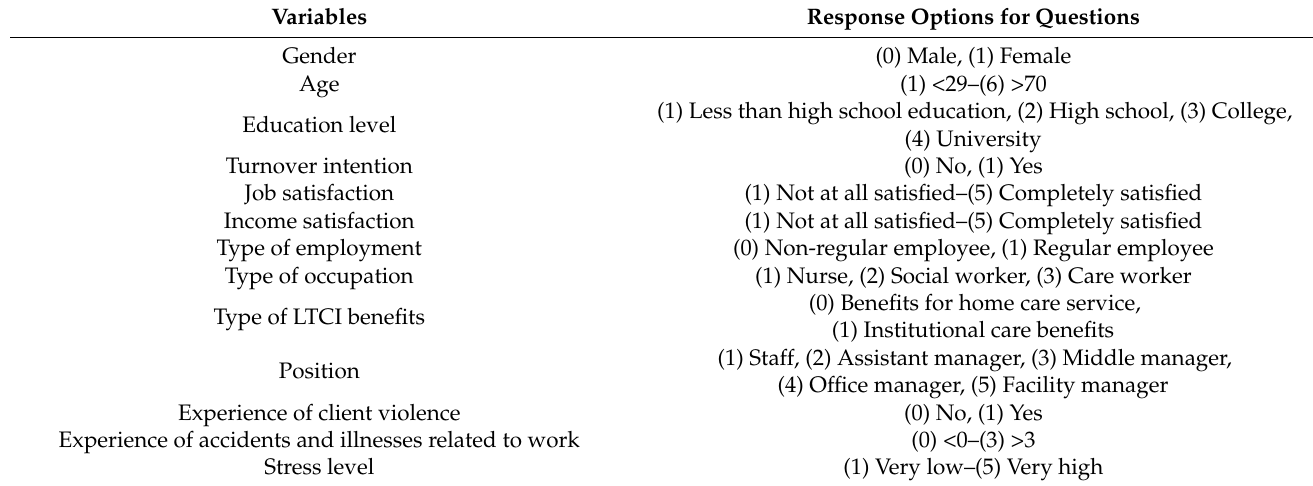
Table 1. Variables included in the logistic regressions with turnover intention as the dependent